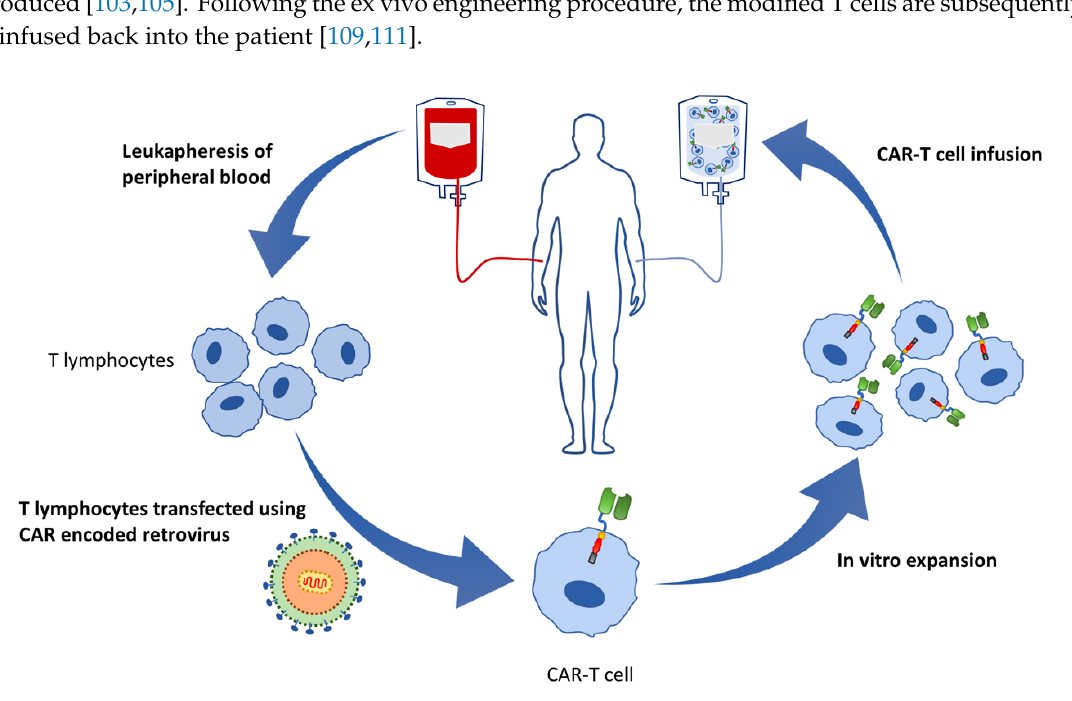
Figure 4. Cycle of the procedure of CAR-T cell production and infusion. Commencing with the harvesting of peripheral blood, from which T cells are separated by leukapheresis. The T lymphocytes are transfected by a viral or non-viral vector, e.g., retrovirus, carrying the genes encoding the CAR sequence in order to modify the T cells with the CAR component. The CAR-T cells undergo expansion and are then infused into the